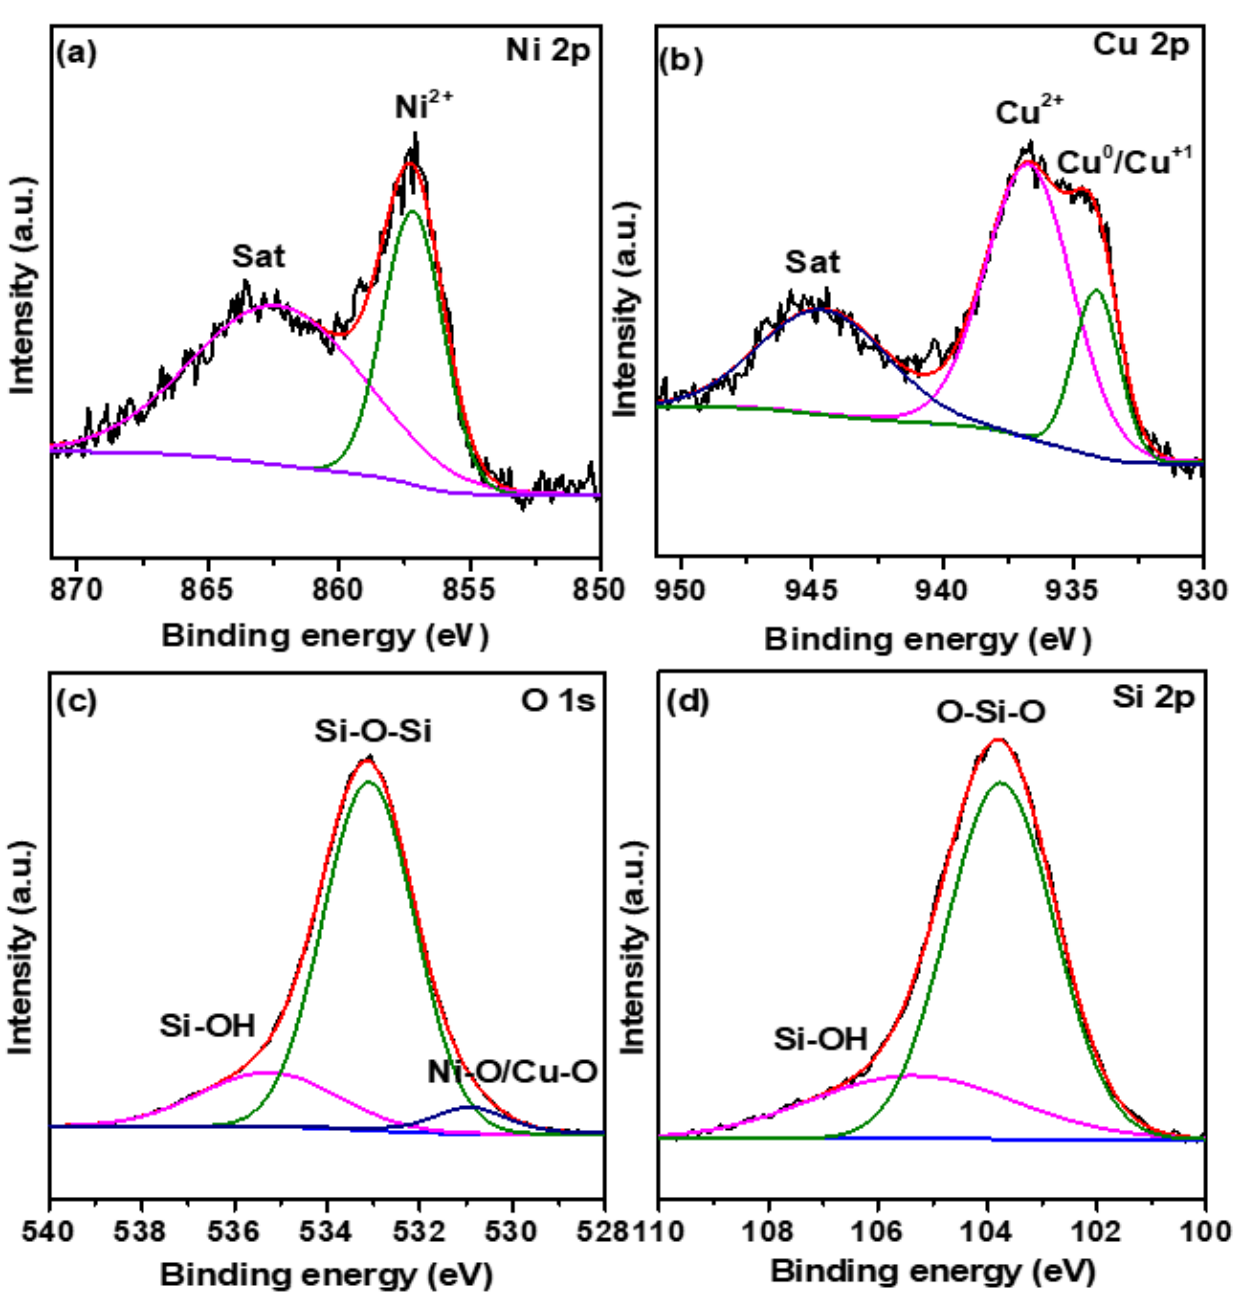
Figure 6. XPS spectra of ( a ) Ni-2p, ( b ) Cu-2p, ( c ) O-1s, and ( d ) Si-2p in the ex situ reduced Ni 5 Cu 15 /m- SiO 2 catalyst.